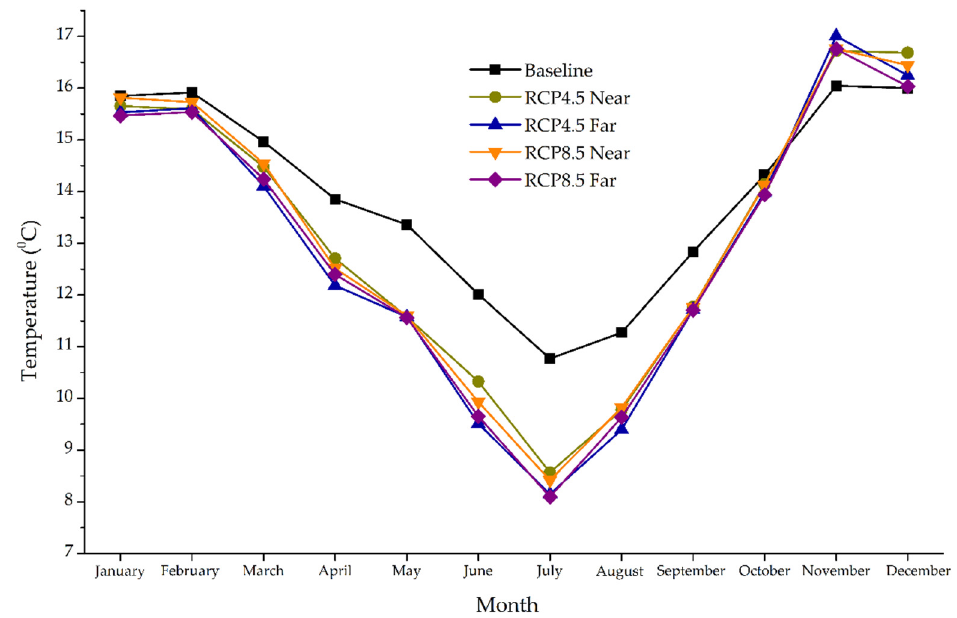
Figure 13. Diurnal temperature range (DTR) for the baseline, near, and far future periods.